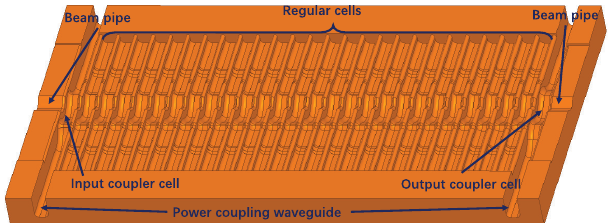
FIG. 14. Geometry of the coupler cell and the full tapered structure. Only one half is